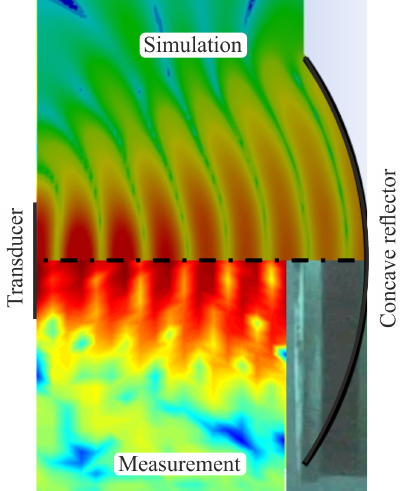
Figure 13. Comparison of simulated and measured field patterns for standing wave system with concave reflector ( R = 72 mm) at a distance of L = 4 λ ; sound pressure (model) and virtual velocity (experiment) are scaled logarithmically; f = 21.4 kHz; ˆ x = 19 µ